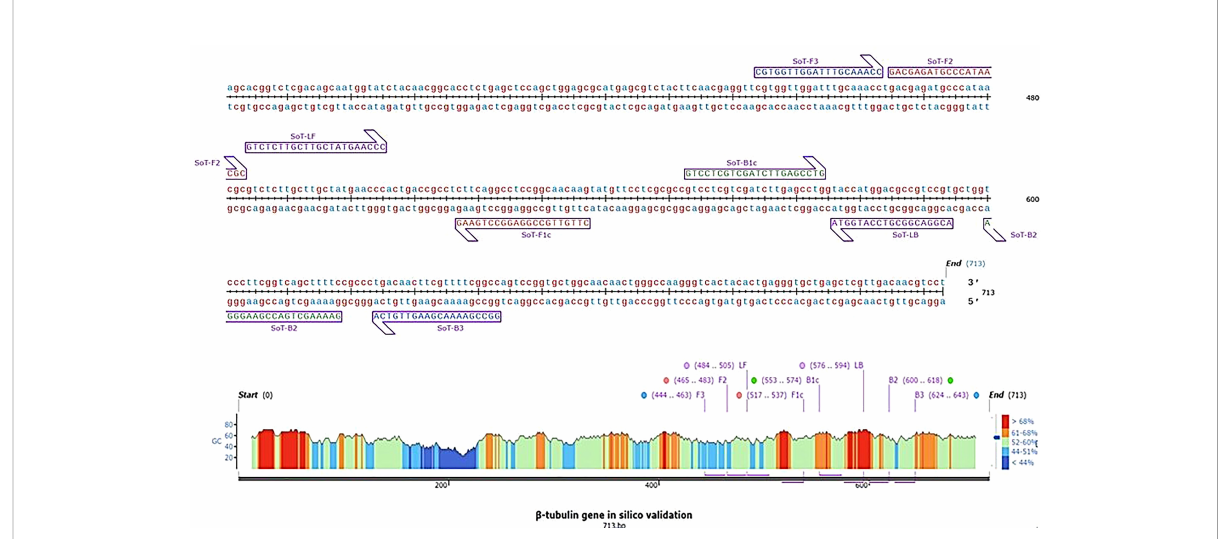
FIGURE 1 Diagrammatic illustration of in silico hybridization of LAMP primers positioned within the b -tubulin (713 bp) domain of the pathogen Sarocladium oryzae visualized using SnapGene viewer ® 6.1.1. Outer primers: F3 and B3 (blue), loop primers: LF and LB (purple), inner primers: F2 and F1c (Red) and B1c and B2 (green).